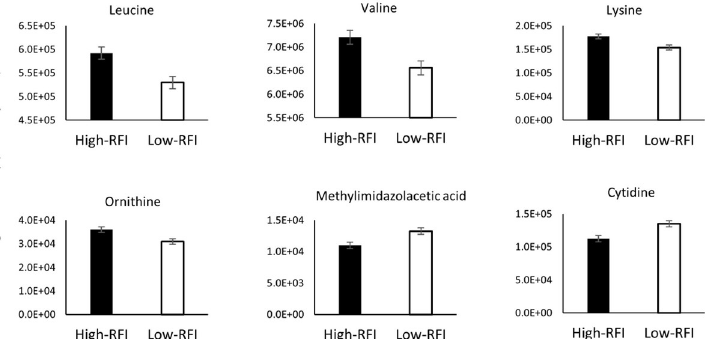
Fig 2. Metabolites identified through ion annotation and further confirmed by standards which were affected (raw-P < 0.05) by residual feed intake class (Low vs High) in beef heifers. High and Low-RFI classes are depicted by black and empty bars, respectively. For leucine and ornithine, only the ion with the highest peak intensity was plotted.